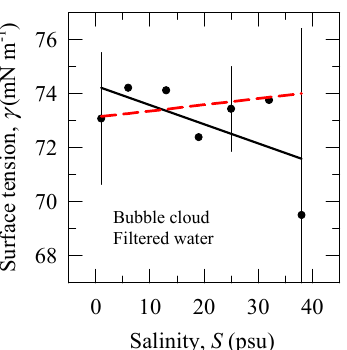
Figure 4. Surface tension γ as a function of salinity S . Solid line is a linear regression fit to the data. Dashed line is expected surface tension of pure NaCl solutions γ 0 (Table 1). The error bars are obtained as percent differences (PD) of two measured samples. We discussed the use of the PD values as the measuring uncertainty in Section 3.3.